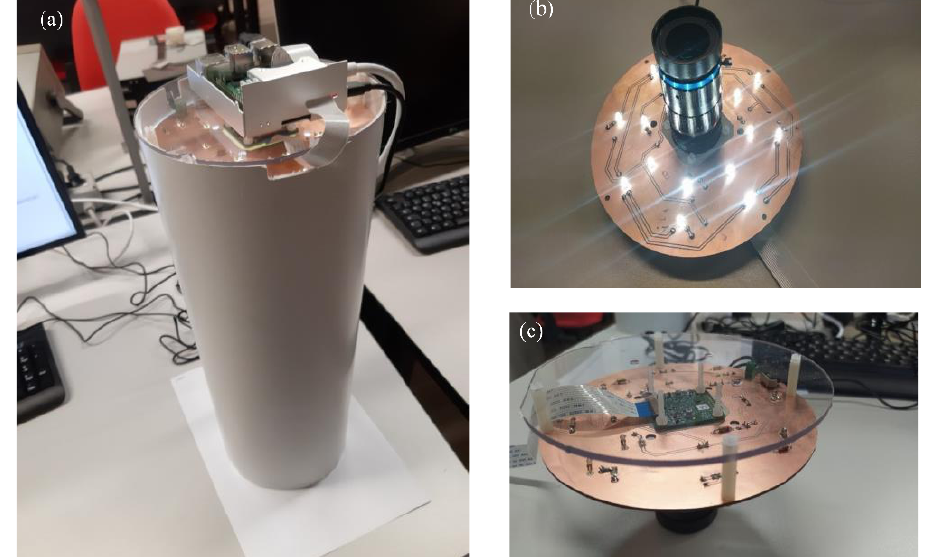
Figure 3. The experimental setup implementing the vision system: ( a ) the whole setup, ( b ) bottom and ( c ) top view of the lighting module assembled with the camera and and ( c ) top view of the lighting module assembled with the camera and lens.